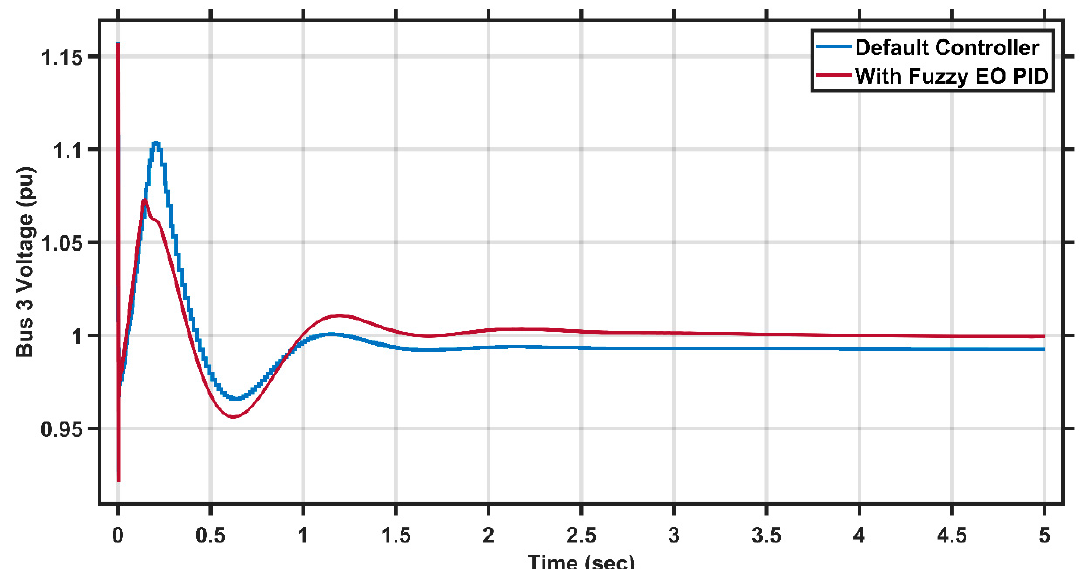
Figure 21. Bus 3 voltage at normal operation for the IEEE 9-bus system.